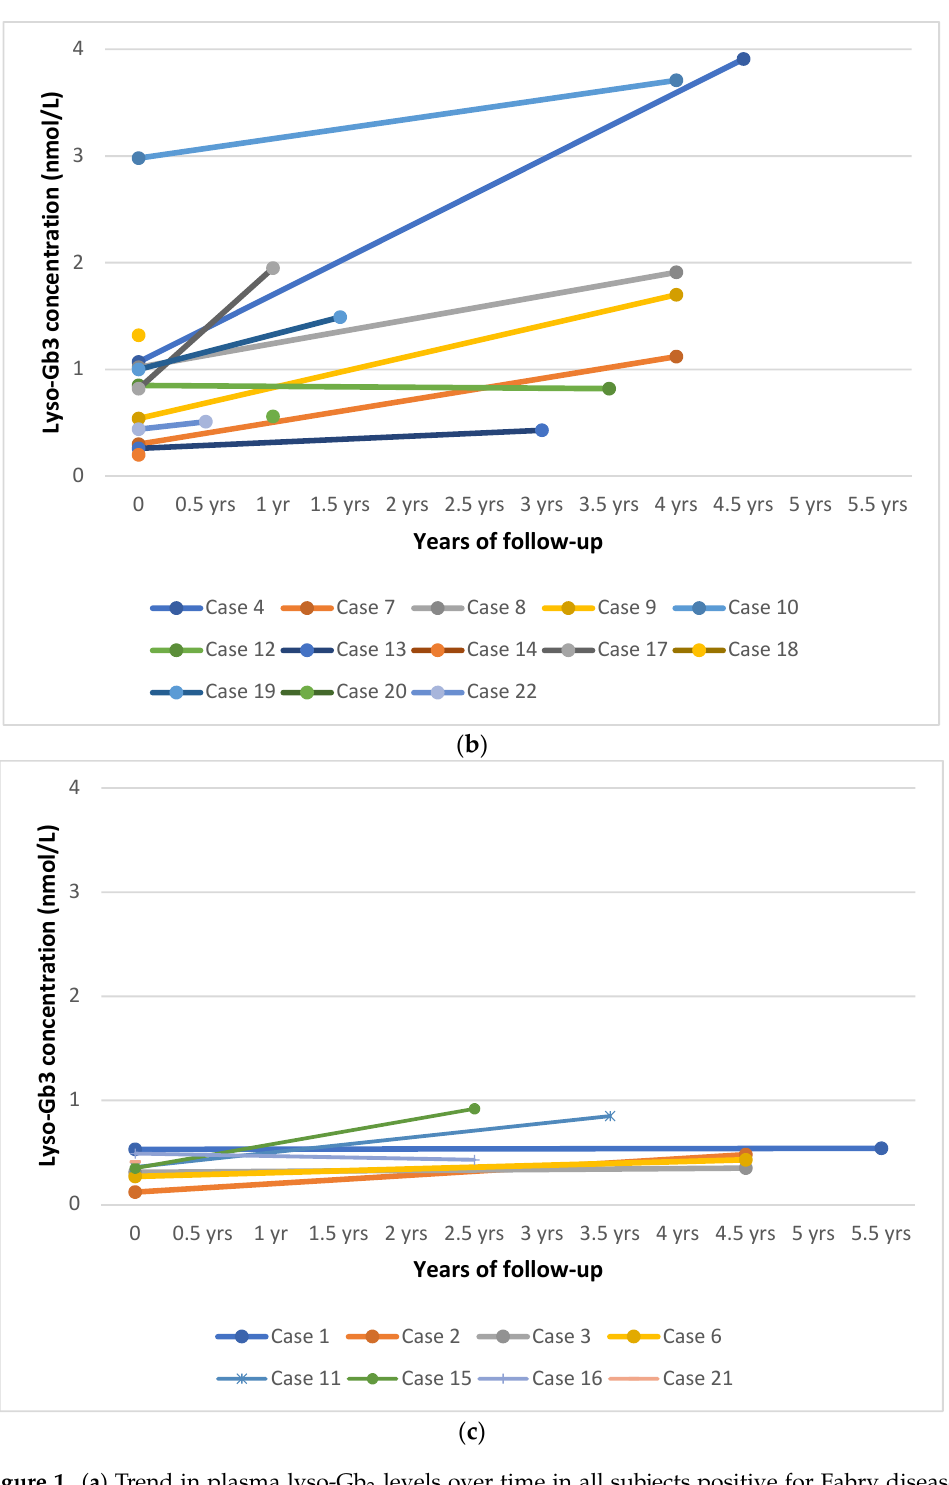
Figure 1. ( a ) Trend in plasma lyso-Gb 3 levels over time in all subjects positive for Fabry disease. ( b ) Plasma lyso-Gb 3 levels over time in patients carrying later-onset variants. ( c ) Plasma lyso-Gb 3 levels over time in subjects carrying benign and unclassified variants (including p.Ala143Thr). Abbreviation: yrs: years